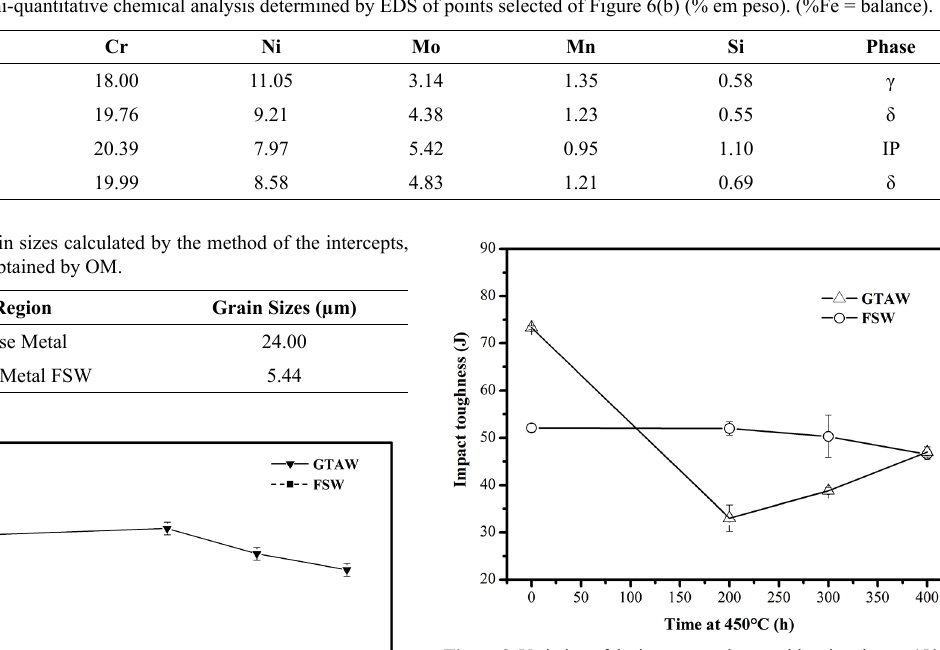
Figure 8. Variation of the impact toughness with aging time at 450